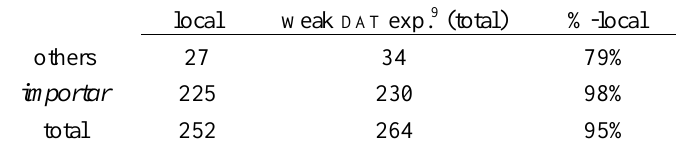
Table 3: (Non-)local identification of weak dative experiencers in adjunct infinitives local weak DAT exp. 9